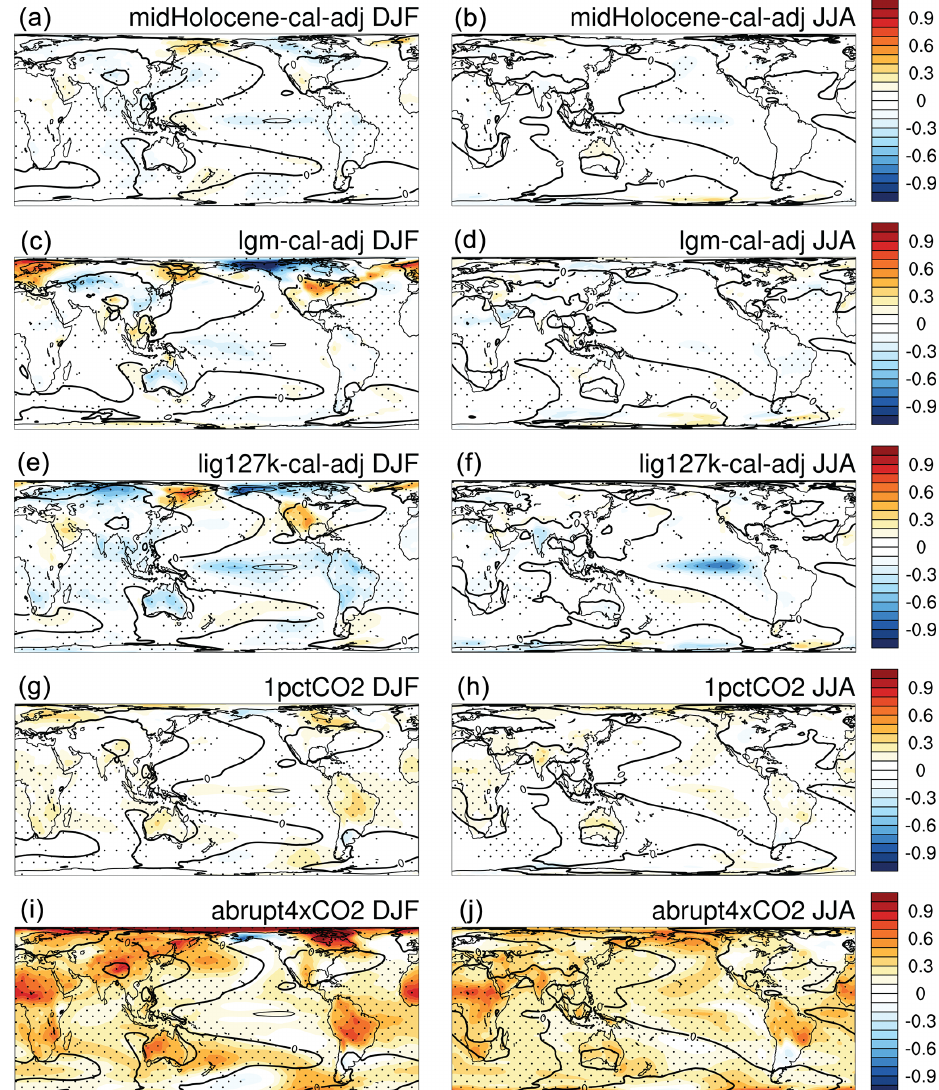
Figure 11. The changes in the seasonal temperature teleconnection pattern associated with ENSO in each experiment compared with the pre-industrial control. The ensemble mean difference between the surface temperature composites of each model’s El Niño minus La Niña (defined as ± 1 standard deviation) in the (a, b) midHolocene , (c, d) lgm , (e, f) lig127k , (g, h) 1pctCO2 , and (i, j) abrupt4xCO2 experiments minus the same pattern for the piControl simulations is shown. The ensemble mean ENSO patterns in the piControl simulations are shown as black contours. Stippling indicates that more than two-thirds of the ensemble members agree on the sign of the